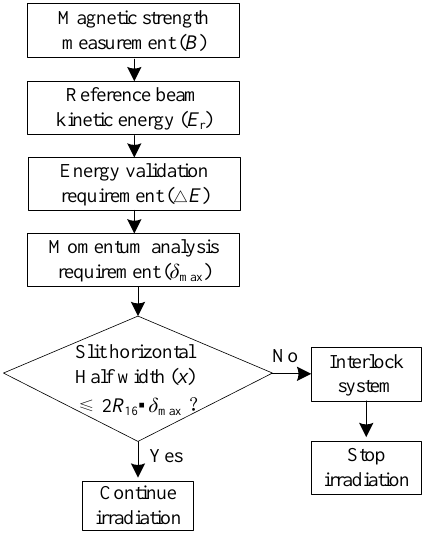
Figure 10. A flowchart of the process in the energy verification system.